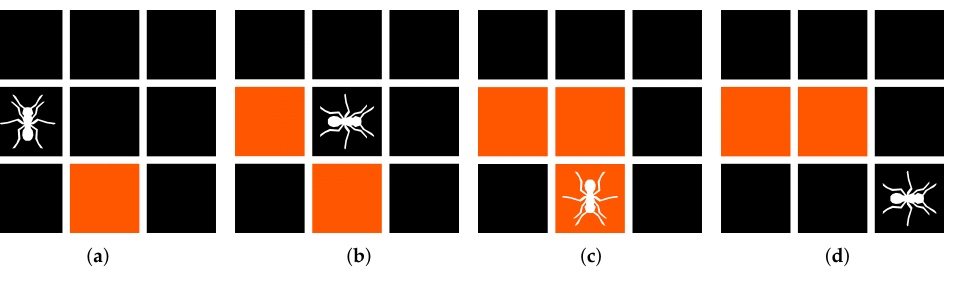
Figure 4. The first 4 iterations of an ant on a 3 × 3 grid. The black cells are OFF, the rest are ON. ( a ) First iteration. ( b ) Second iteration. ( c ) Third iteration. ( d ) Fourth iteration.